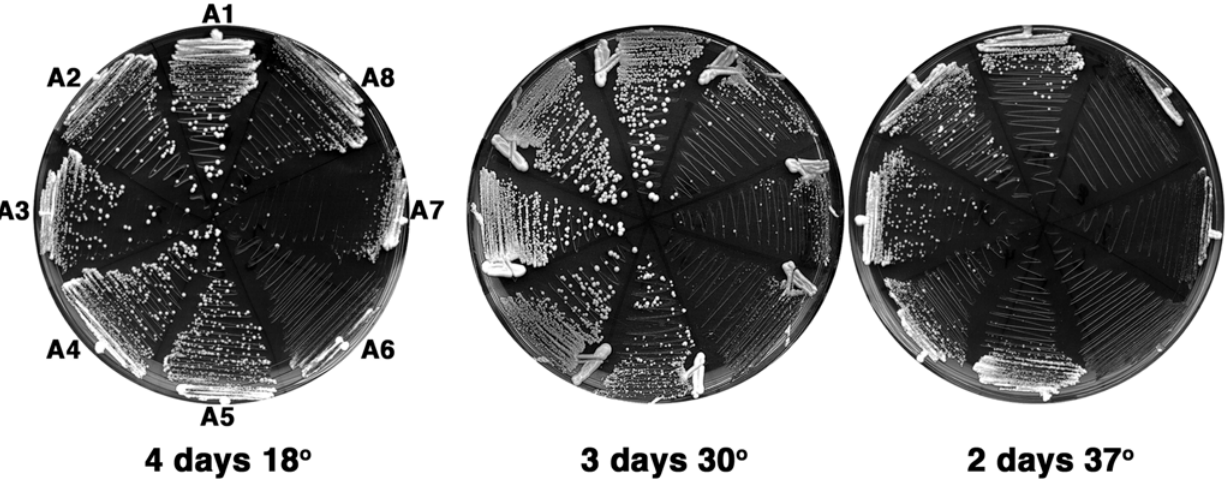
Figure 2. Growth of S.cerevisiae expressing individual Ssa proteins. G402 strains A1–A8 [ psi 2 ] cells were streaked onto YPAD plates and incubated at the indicated temperature for 2–4 days as indicated. Strains are as indicated on first panel, pattern of strains is the same on each plate.